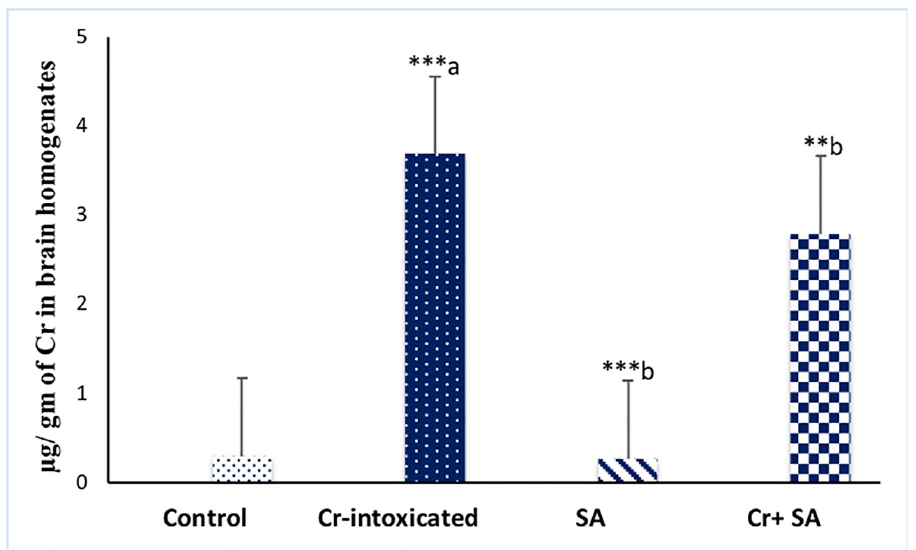
Fig 1. Cr concentration in brain tissues of the studied groups. Data are expressed as mean ± SE (n = 10). ��� a p � 0 . 001 and ��� b p � 0 . 001 compared to standard control and Cr-intoxicated groups, respectively. �� b p � 0 . 01 compared to Cr-intoxicated